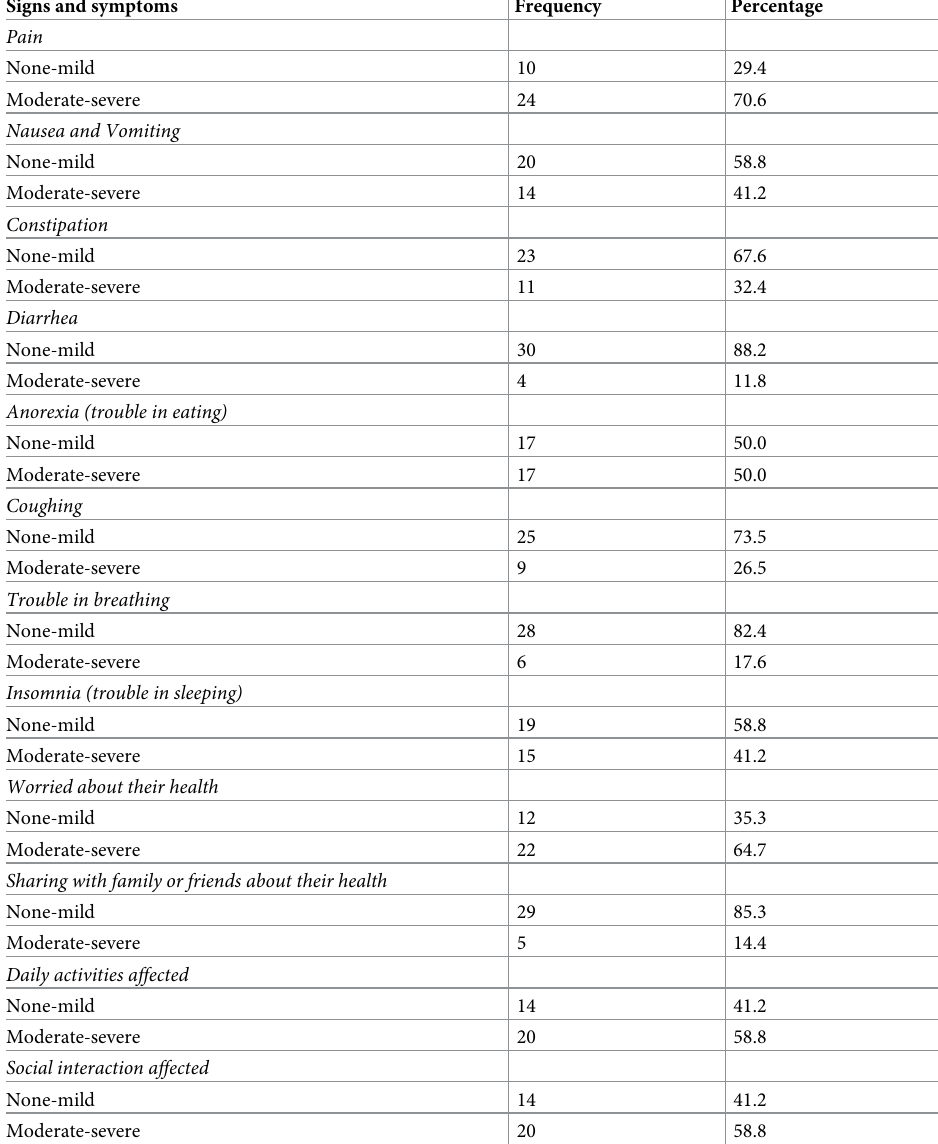
Table 3. Ratings of patients’ signs and symptoms using the adjusted African Palliative Outcome Scale (POS). Signs and